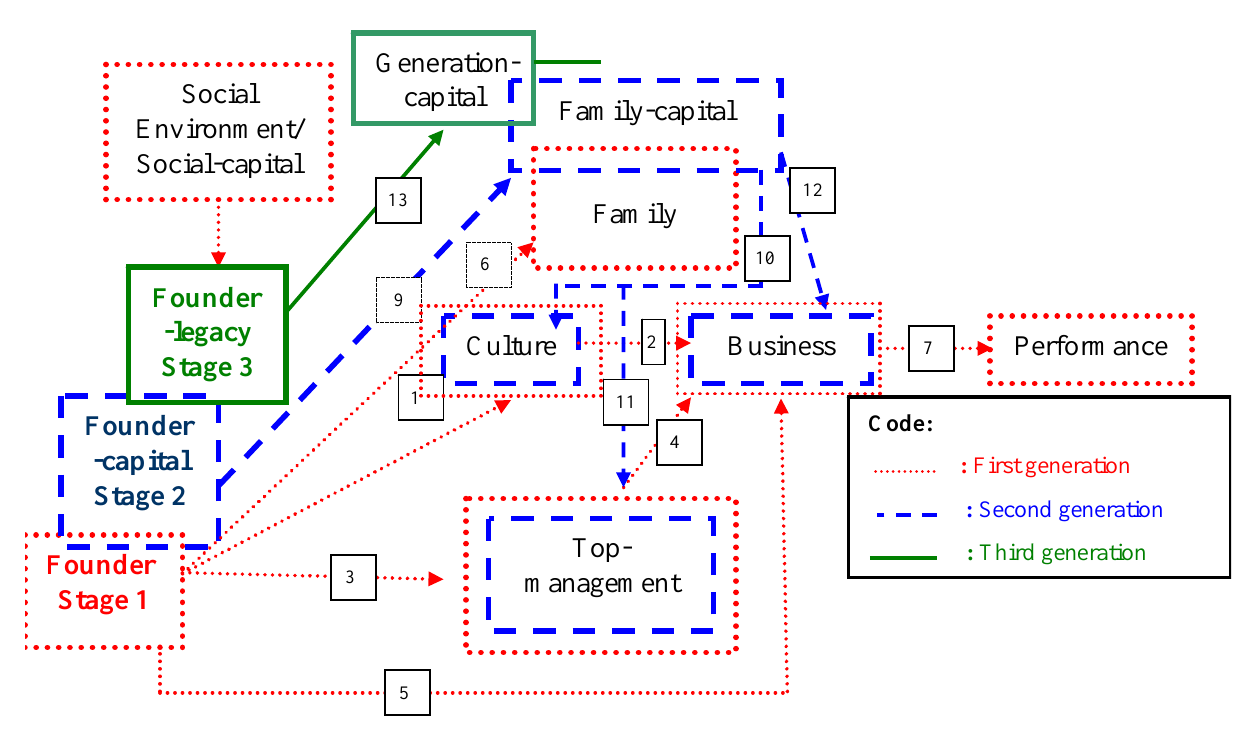
Figure 6: A proposed familiness Transmission of Capital Model